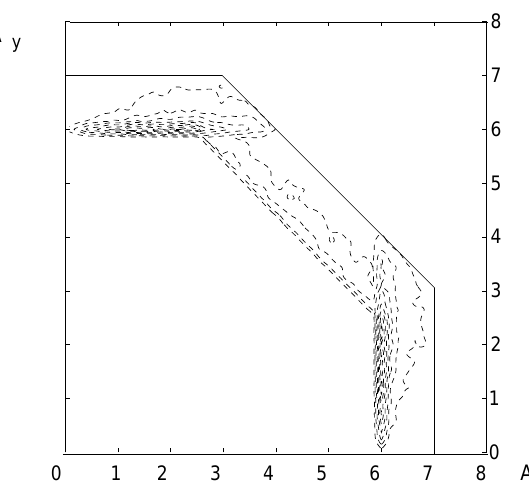
FIG. 4. The contour plot of the distribution (cid:100) (cid:50) (cid:78) (cid:121) (cid:100)(cid:65) (cid:120) (cid:100)(cid:65) (cid:121) of the secondary halo in the case (cid:109) (cid:112) (cid:173) (cid:51) and (cid:109) (cid:115) (cid:173) (cid:52) with continuous primary impact distribution. This distribution is obtained with isotropic scattering. The normalized amplitudes (cid:65) (cid:120) and (cid:65) (cid:121) are in rms beam units. We used collimator apertures (cid:110) (cid:49) (cid:173) (cid:54) and (cid:110) (cid:50) (cid:173) (cid:55) . The two octagons of inner radii (cid:110) (cid:49) and (cid:110) (cid:50) indicate that the secondary halo is almost entirely contained inside these limits.